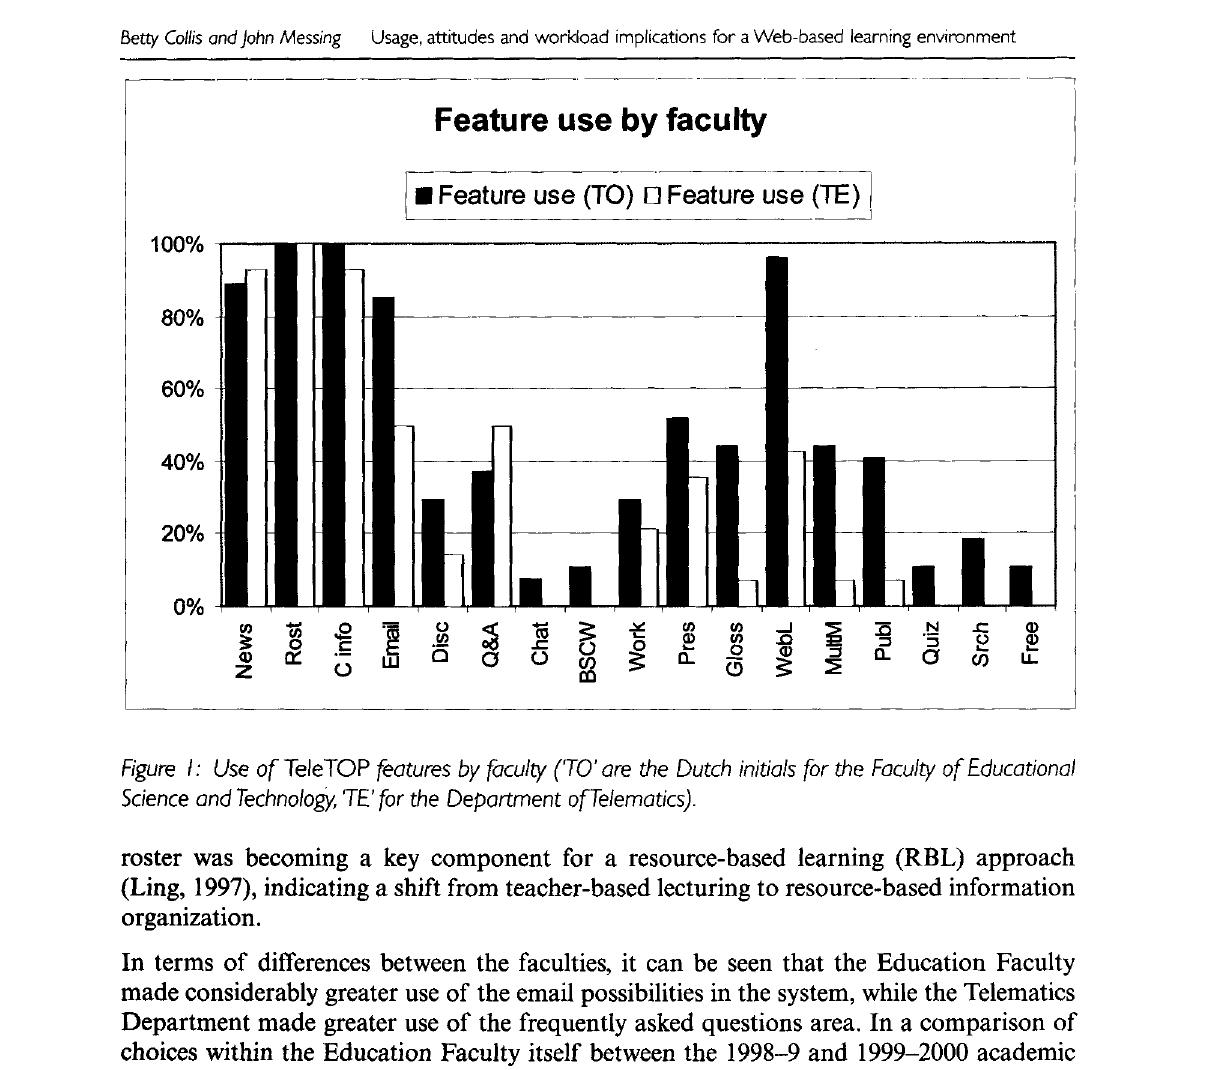
Figure h Use of TeleTOP features by faculty ('TO' ore the Dutch inidals for the Faculty of Educational Science and Technology, TE' for the Department of